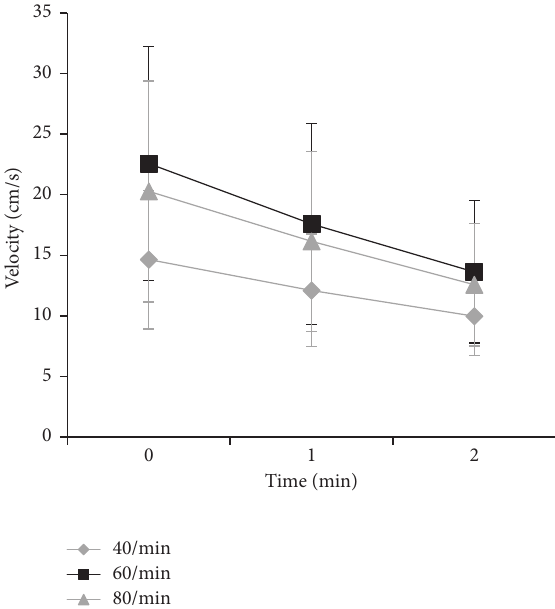
Figure 3: Velocity of blood flow in the profunda femoris after active ankle movement prior to total hip arthroplasty (mean ± standard deviation). The velocity of venous blood flow after active ankle movement at 60 contractions per minute was significantly faster thanthoseafteractiveanklemovementat40and80contractionsper minute ( 𝑝 = 0.0001 , repeated-measures ANOVA). The horizontal line indicates the time after active ankle movement.